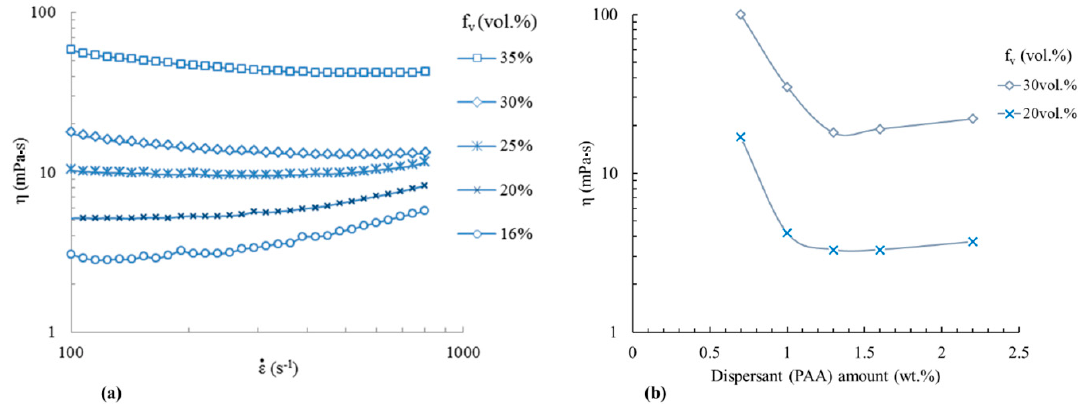
Figure 3. Evolution of suspensions’ viscosity at pH = 9 as a function of sharing stress for various particle volume fractions (f v ) for 1.3 wt.% of ammonium polyacrylate (PAA) ( a ) and evolution of the viscosity at (cid:2013)(cid:4662) = 100 s − 1 as a function of the dispersant amount for f v = 20 and 30 vol.% ( b ).